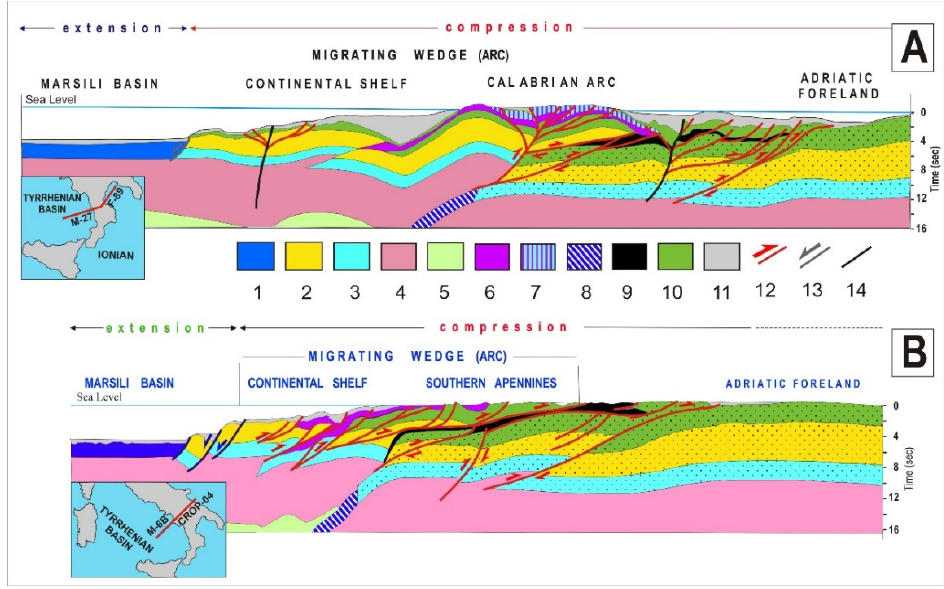
Figure 11. ( A ) CROP section from the Marsili basin to Adriatic foreland through Northern Calabria (modified after [49]). (1) Oceanic crust; (2) upper continental crust; (3) lower continental crust; (4) Lithospheric mantle; (5) Asthenospheric mantle; (6) remnants of the Alpine Tethys; (7) Kabylo–Calabrides units; (8) Ionian Tethys oceanic slab; (9) Ionides; (10) pre-Pliocene sedimentary cover; (11) Pliocene–Quaternary sediments; (12,13,14) major thrust, normal and strike-slip faults developed during the formation of the Tyrrhenian basin. Dots mark the Adriatic crustal units (from Mantovani et al., 2007, modified). ( B ) CROP cross section from the Southernmost Tyrrhenian (Marsili basin) to the Adriatic foreland, through the Southern Apennines (modified after [150]).